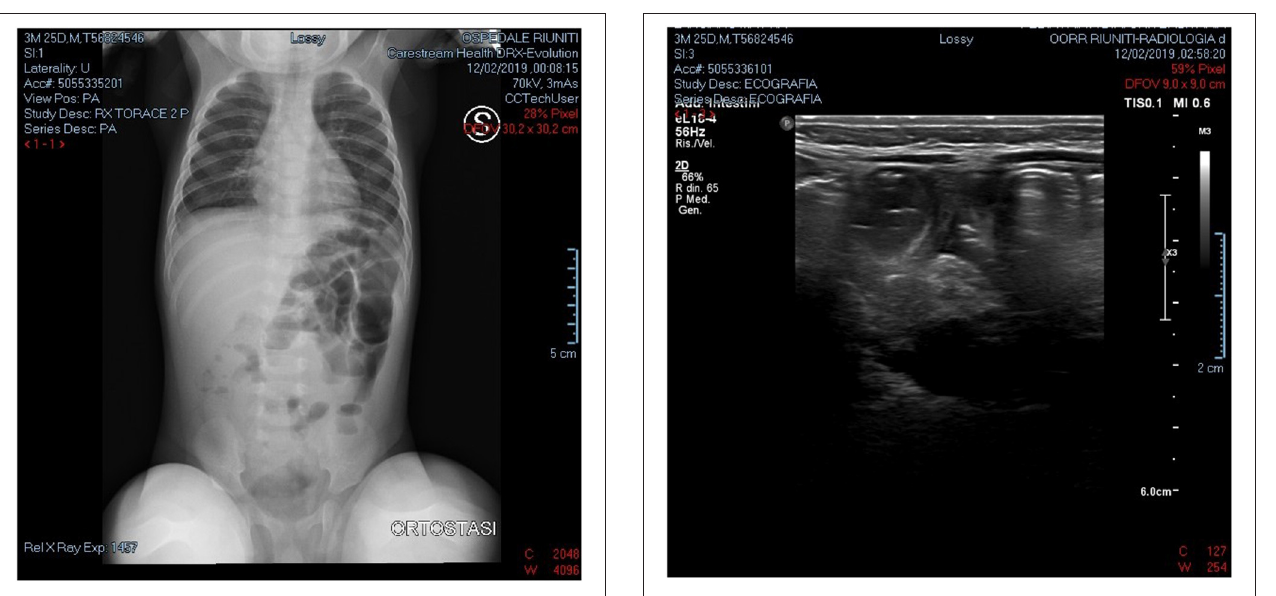
FIGURE 1 | Plain abdominal x-ray showed air fluid levels. FIGURE 2 | Abdominal US demonstrated a large sub hepatic fluid collection.